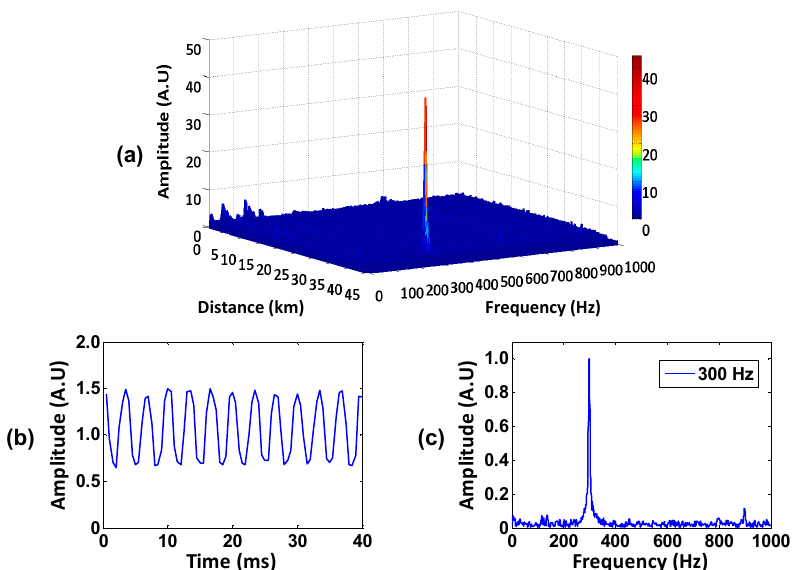
Figure 4. ( a ) The auto-power spectrum of vibration along the sensing fiber; ( b ) the time domain signal and ( c ) the frequency spectrum of the vibration with the peak of 300 Hz. By subtracting the amplitude traces from the first trace and computing the sum of the absolute amplitude change [11,12], the vibration location curve is shown in Figure 5a. The achieved SNR of the intrusion signals reaches up to 21.4 dB at the vibration position of 40.45 km (the SNR is calculated as the ratio between the peak intensity of the vibration signal and the root-mean-square intensity of the background noise) [11]. The vibration was applied along 1.5 m of fiber at the vibration position. In the experimental results, one point represents one meter since the sample rate of 100 MS/s was used in these experiments. Figure 5b shows that the full width of the vibration location is about 12 m (40,446–40,458 m). That means the spatial resolution is ~12 m without any further processing [22]. Considering the pulse-broadening caused by the AOM (the optical pulse modulated by the AOM has a rising edge over 10 ns), it is in good agreement with the probe pulse width of 100 ns [22].